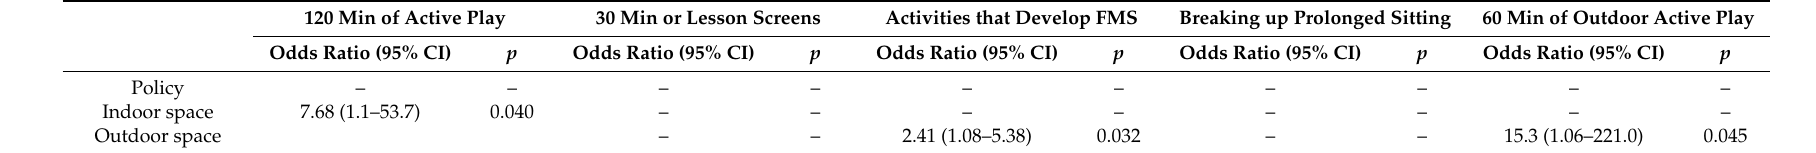
Table 6. Policy and environmental correlates of Active Play standards for childcare facility sta ff